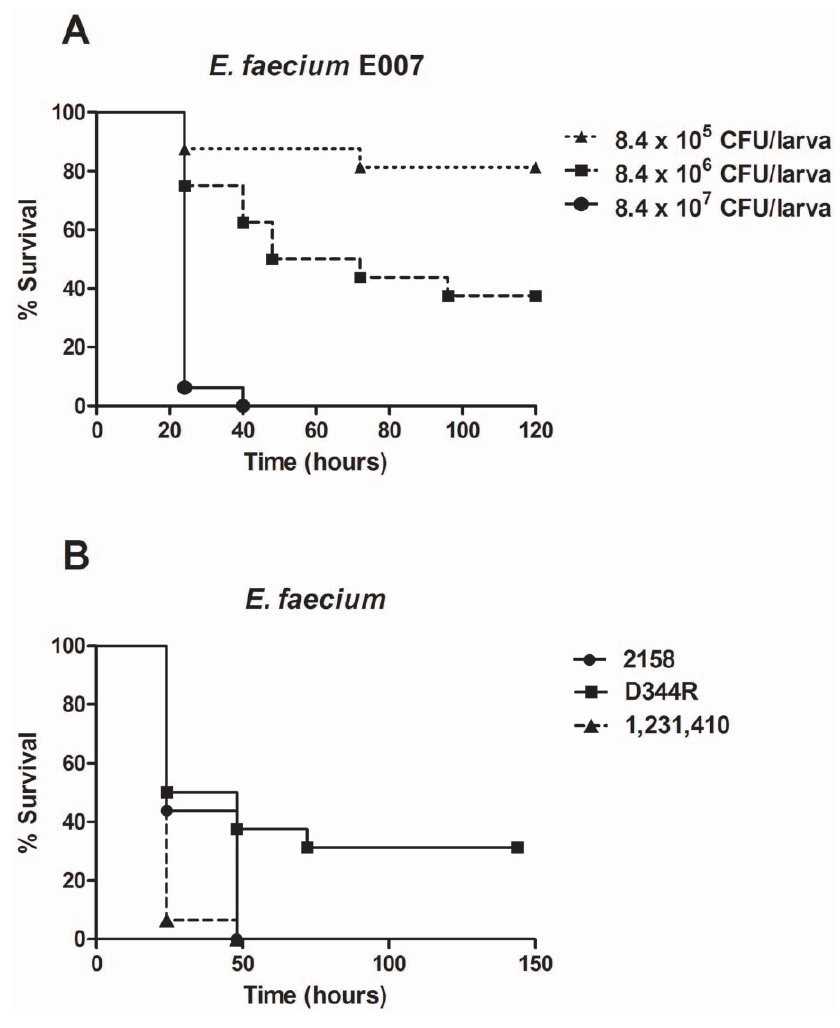
Figure 1. Killing of G.mellonella larvae by E.faecium . Comparison of survival curves by Log-rank test: A) G. mellonella survival after injection of different inocula of E. faecium (10 5 , 10 6 or 10 7 CFU/larva) and maintained at 37 u C. Injection with 8.4 6 10 7 CFU/larva resulted in significantly higher death rate, compared to injection with 8.4 6 10 6 CFU/larva ( P =0.0001) or 8.4 6 10 5 CFU/larva ( P =0.0001). Injection with 8.4 6 10 6 CFU/larva resulted in significantly higher death rate compared to injection with 8.4 6 10 5 CFU/larva ( P =0.0139). B) Killing of G. mellonella by E. faecium D344R ampicillin resistant (3.0 6 10 7 CFU/larva), E. faecium 1,231,410 vancomycin resistant (4.8 6 10 7 CFU/larva) and E. faecium 2158 that was tested previously in mouse peritonitis model (1.25 6 10 7 CFU/larva). A representative example was used for each